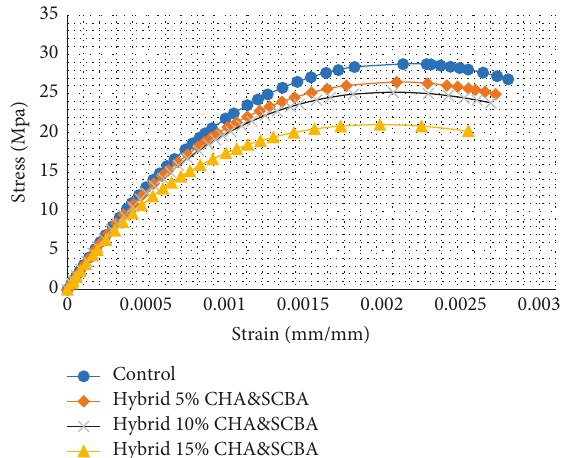
Figure 12: Stress-strain curve of test specimens at 28th